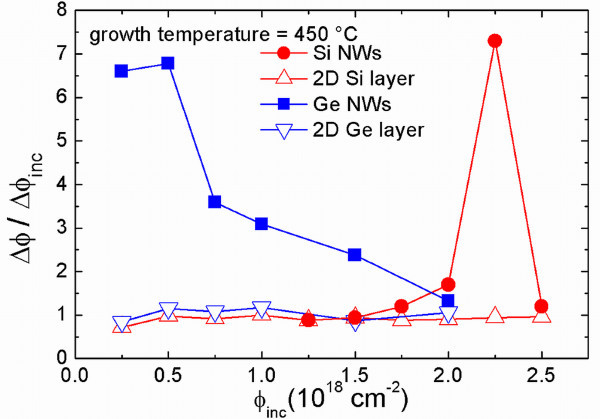
Increment of the fluence ΔΦ of both the NWs, and the planar rate over the increment of evaporated incident fluence ΔΦinc, as a function of the evaporated fluence Φinc. In particular, in the case of the NW, ΔΦNW has been calculated as the increment of the areal densities of atoms contributing to the NW growth. This ratio represents the axial growth rate of the NW derived with respect to the evaporated fluence.